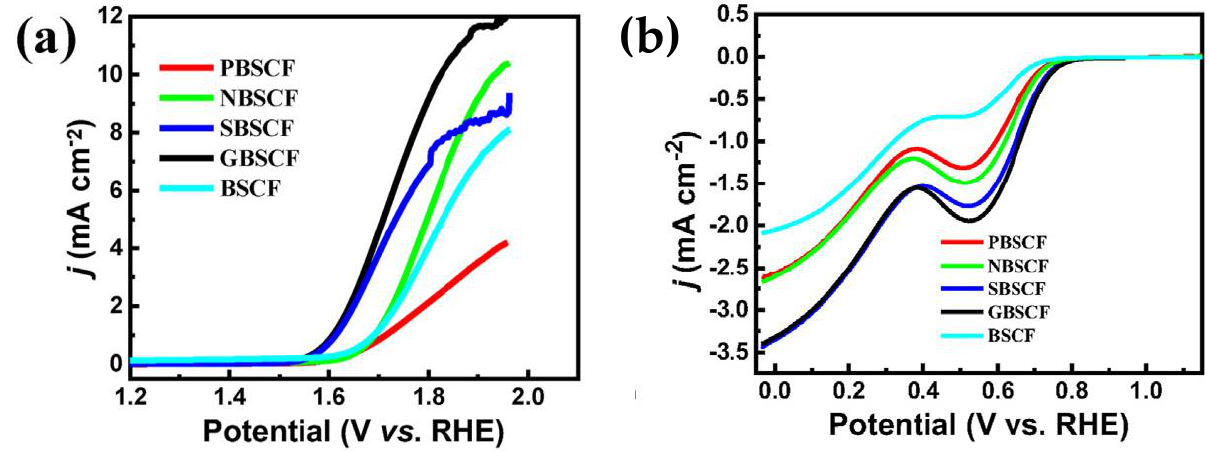
Figure 8. LSV of developed catalysts for ( a ) OER process and ( b ) ORR process at 1600 RPM in 0.1M KOH at a scan rate of 10 mV s –1 . Copyright 2020 by the Elsevier Ltd. [66].